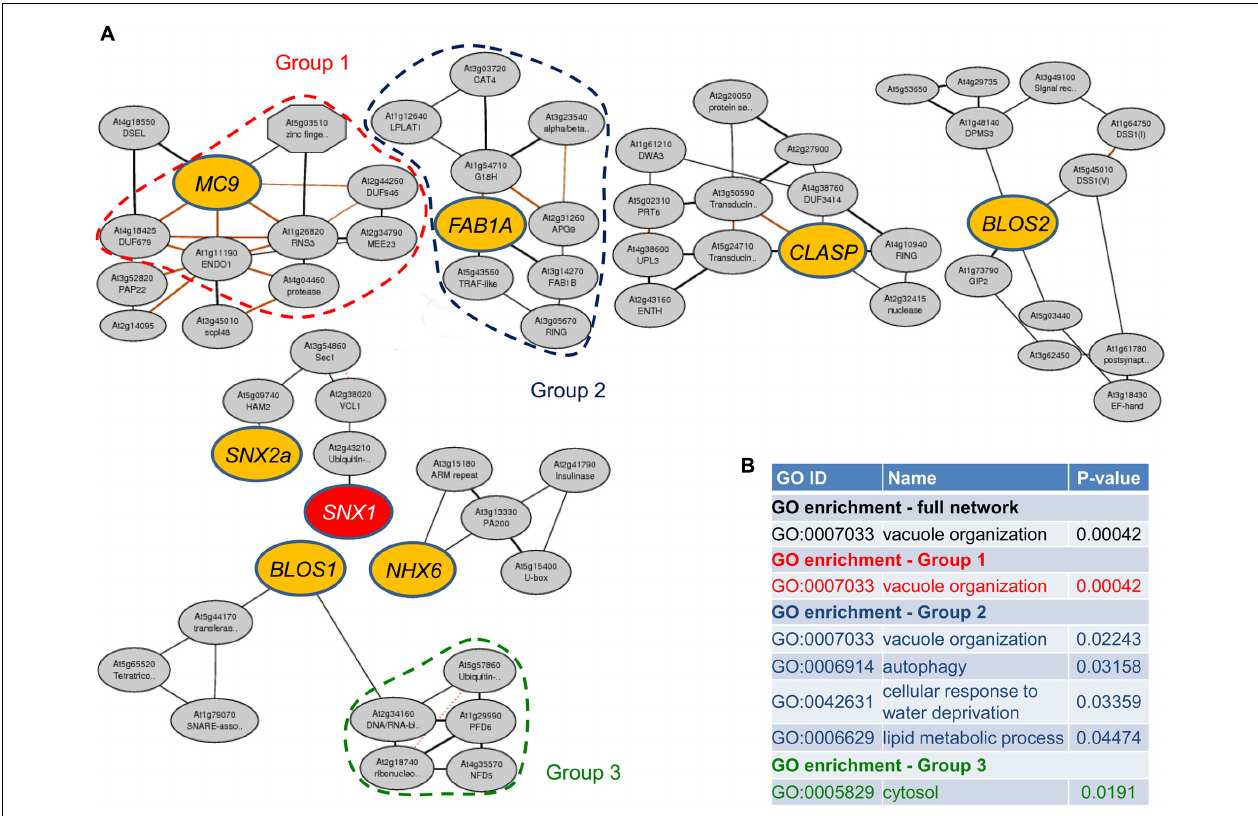
FIGURE 2 | SNX1 interactome-related coexpression networks. (A) Genes encoding SNX1-interacting proteins (colored ovals) were used as a basis for the generation of the coexpression networks using the ATTED-II server. (B) Enriched gene ontology (GO) categories. The color code corresponds to the three groups of genes showing GO enrichment encircled with punctate lines in (A)